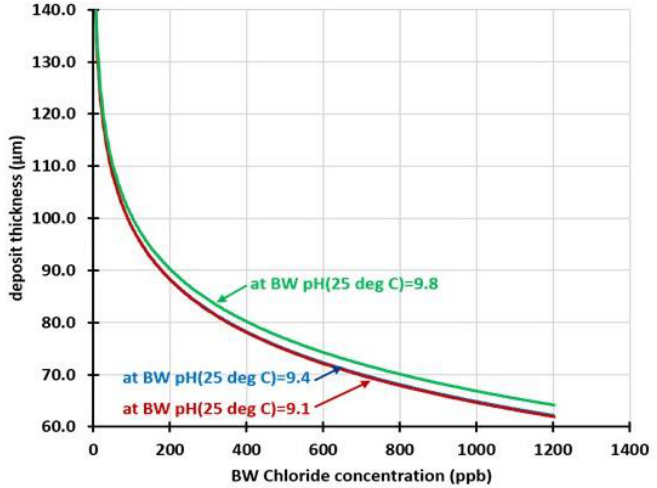
Figure 6. The critical deposit thickness required to generate the local pH beneath the deposit required to cause rapid UDC, as a function of the bulk pH and chloride concentration, for the boiler design and tube materials considered in Figure 5 [19].